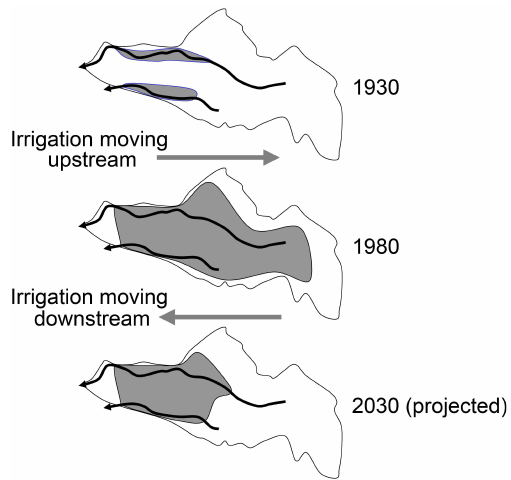
Fig. 5. Schematic of the evolution of the spatial patterns of irrigation (shaded area) in the Murrumbidgee. In the early 20th century irri- gation moved upstream. Recently, the government has started buy- ing water rights from farmers to protect the environment. Bottom panel is a projection based on cutting back irrigation upstream, re- produced with permission from Sivapalan et al.